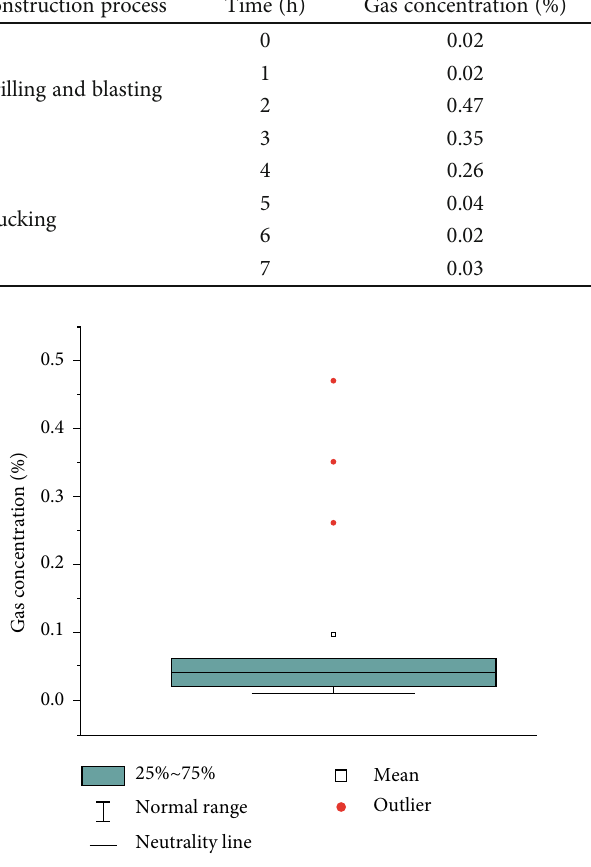
Figure 2: Box plot of gas concentration in di ff erent construction processes.